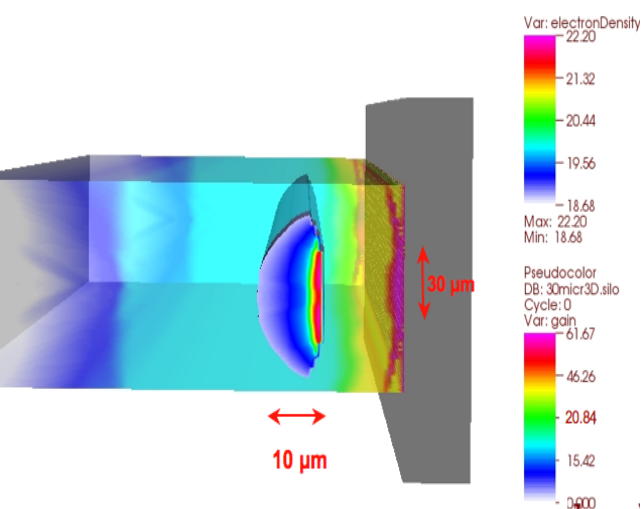
Figure 1. Image in false colors of plasma created by two laser pulses and the gain region. This modeling has been used to benchmark ARWEN code against Wang et al. ’s experiment.